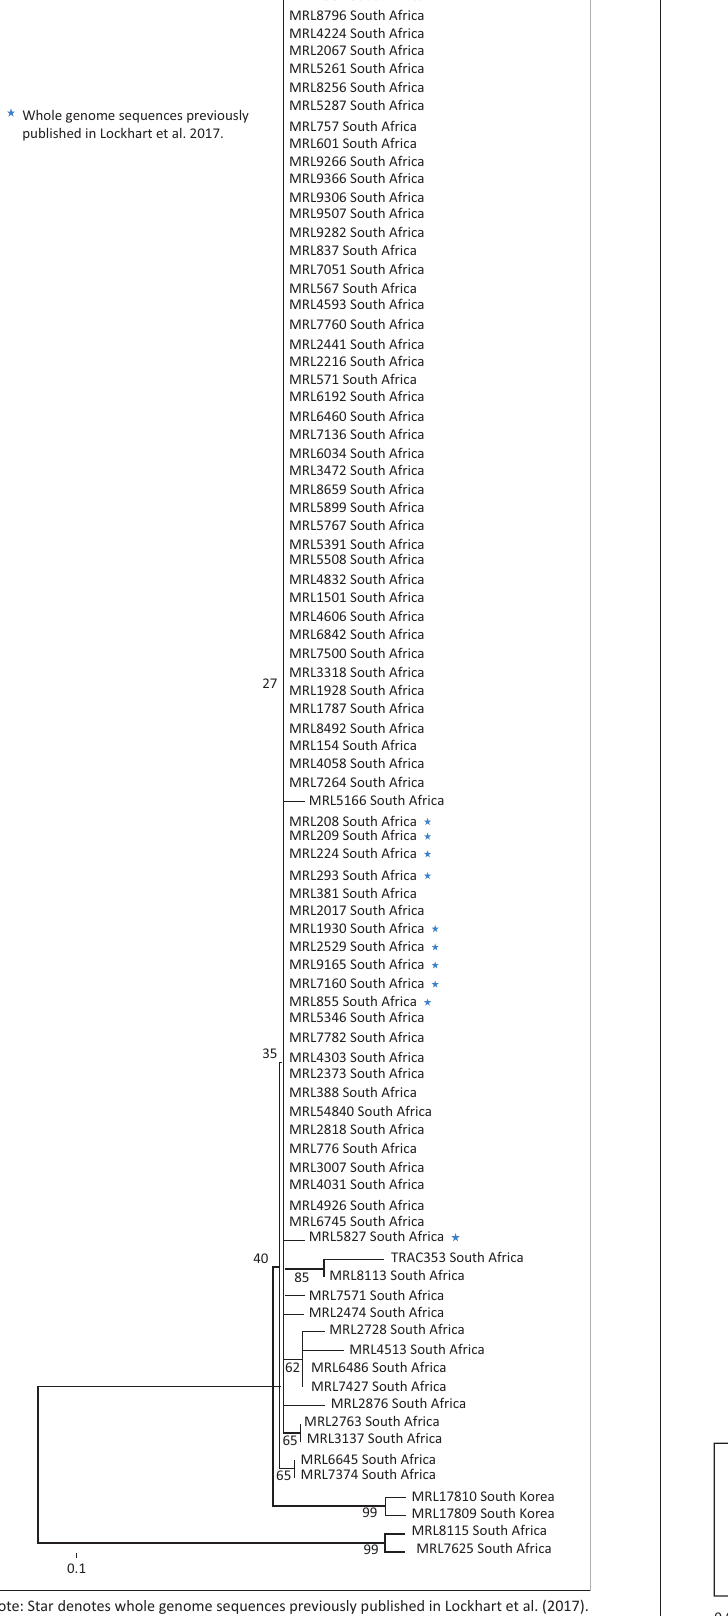
FIGURE 1: Phylogenetic tree based on multilocus sequence typing (MLST) data of South African Candida auris ( n = 85) isolates using the neighbour-joining analysis method with 2000 bootstrap replications. Sequences of South Korean reference strains (KCTC17809 and KCTC17810) were retrieved from the